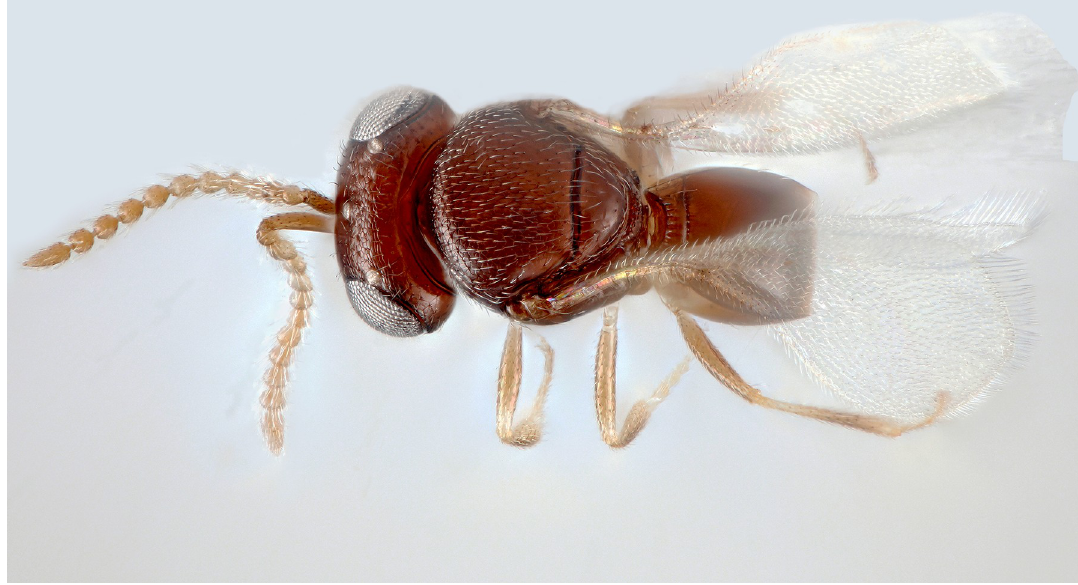
Fig 2. Telenomus nizwaensis Polaszek male holotype. Dorsal habitus. https://doi.org/10.1371/journal.pone.0250464.g002 absent. Frons moderately convex between inner orbits and toruli; eyes setose; malar region smooth; malar sulcus present; gena with reticulate sculpture behind eyes. Antennae 11-merous.